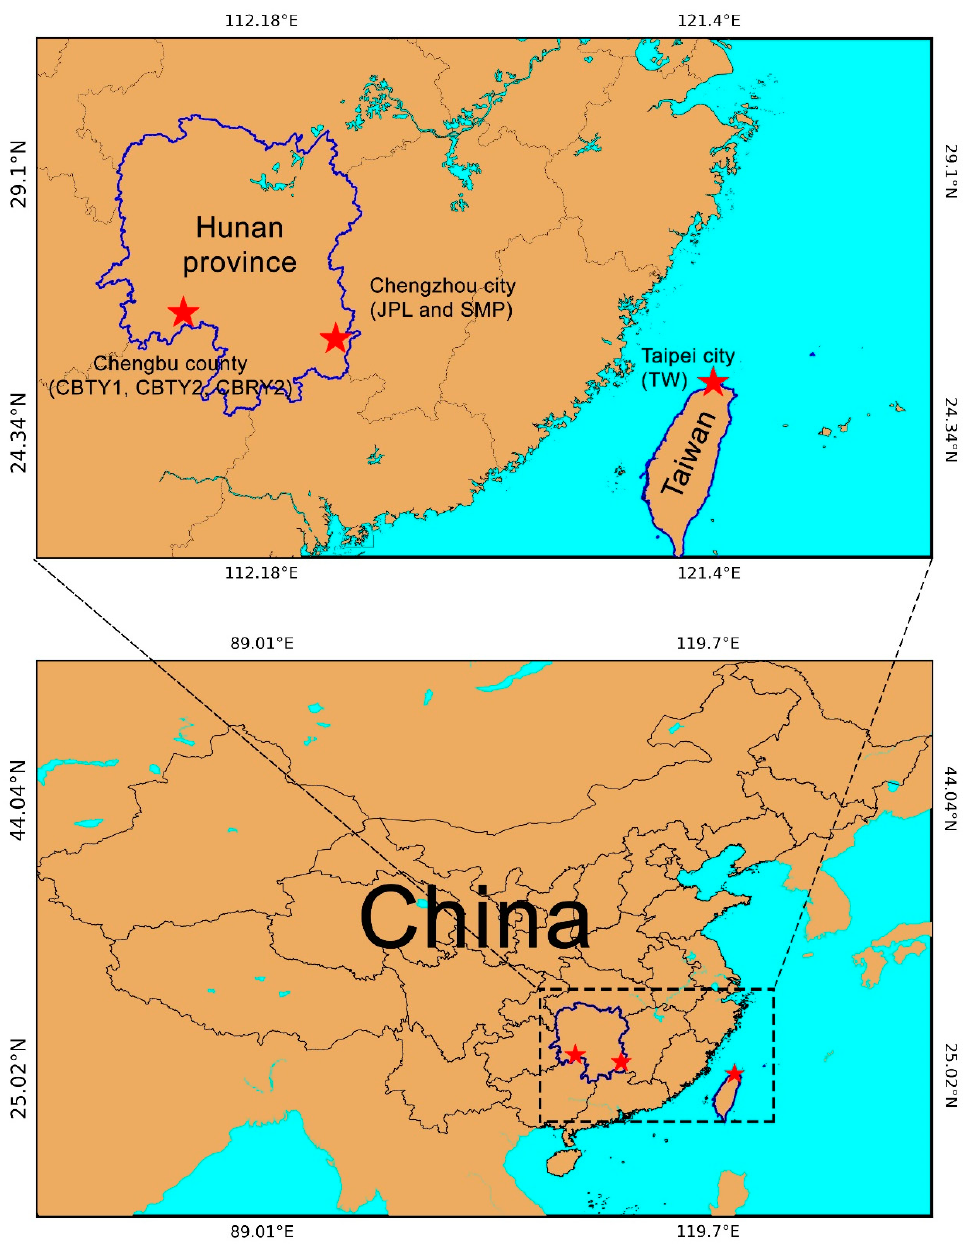
Figure 1. The locations of Cathaya argyrophylla populations sampled for this study. Stars indicate different cities or counties. Sample IDs are provided in parentheses.